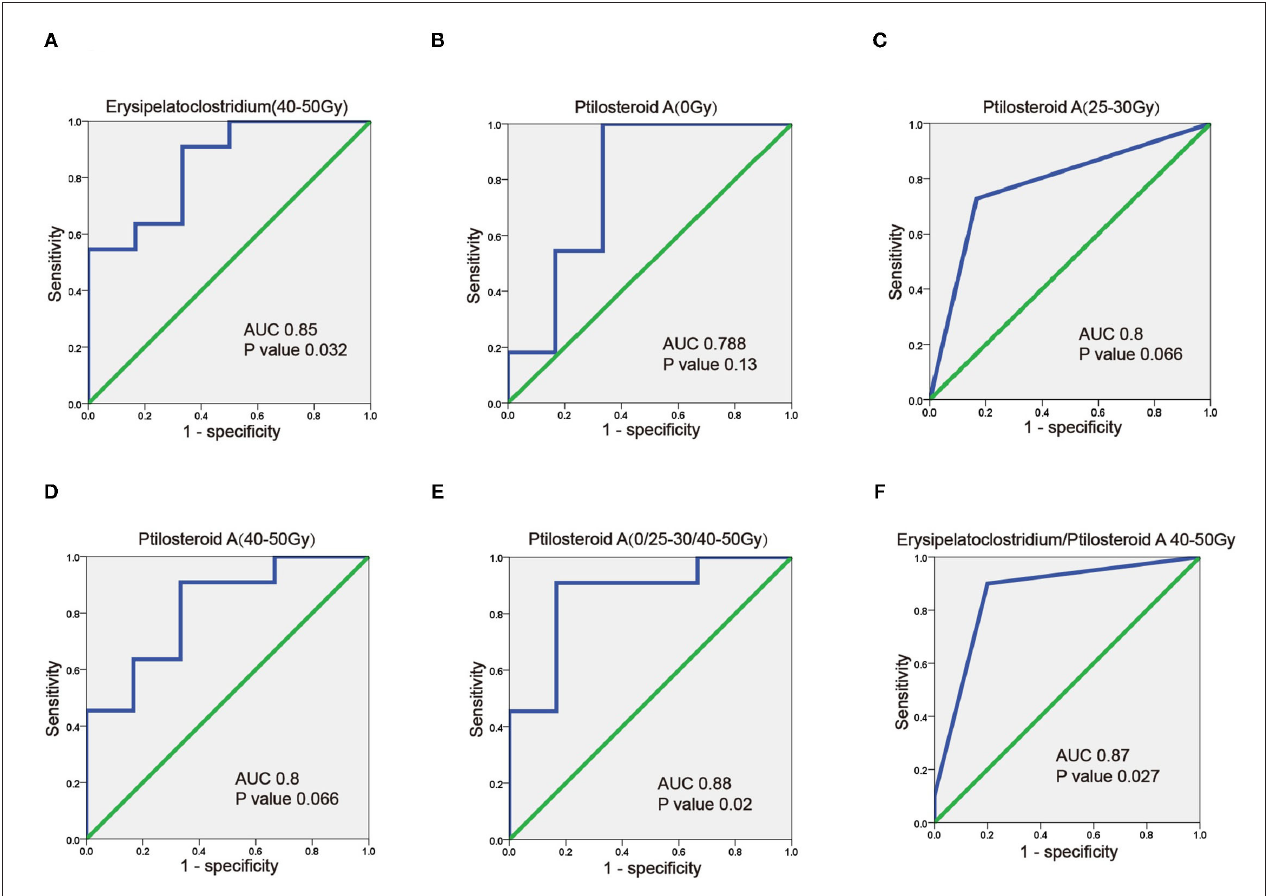
FIGURE 5 | Predictive value of gut microbiome and metabolites for predicting RIII. (A) ROC plot for Erysipelatoclostridium after 45–50Gy. (B–D) ROC plot for ptilosteroid A at 0Gy, after 20–30 and 45–50Gy. (E) The ROC analysis of the combination of ptilosteroid A at all the three timepoints. (F) The ROC analysis of the combination of Erysipelatoclostridium and ptilosteroid A.